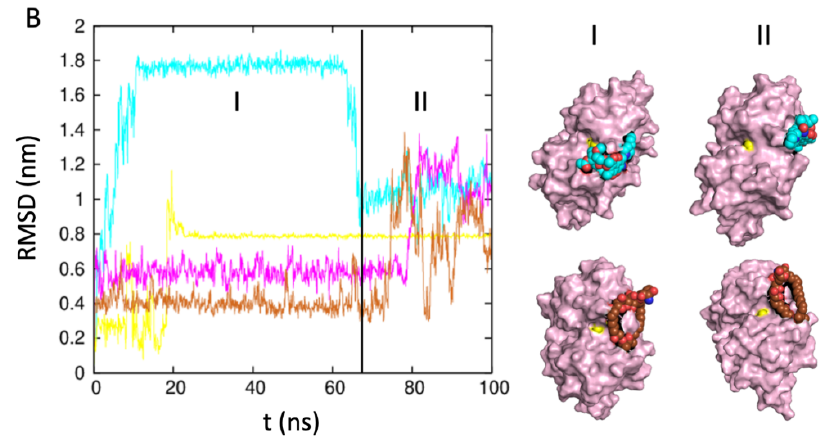
Figure 6. Changes in protease activity of catL upon introducing our proposed small molecules and mechanistic explanation of their effects. ( A ) catL protease activity upon addition of SID 26681509, Rifapentine, Digoxin, Nystatin and Drospirenone. RFU stands for relative fluorescence units. ( B ) RMSD trends of tested drugs (Rifapentine, Digoxin, Nystatin and Drospirenone) in complexes with catL. On the right, two snapshots of our hit drug candidates, Rifapentine (cyan) and Nystatin (brown), in complex with catL (pink) from the start (I) and the end (II) of the simulations are shown. This suggests that the interaction of Rifapentine and Nystatin with the catL active site (shown with yellow sphere) stabilizes the whole complex.